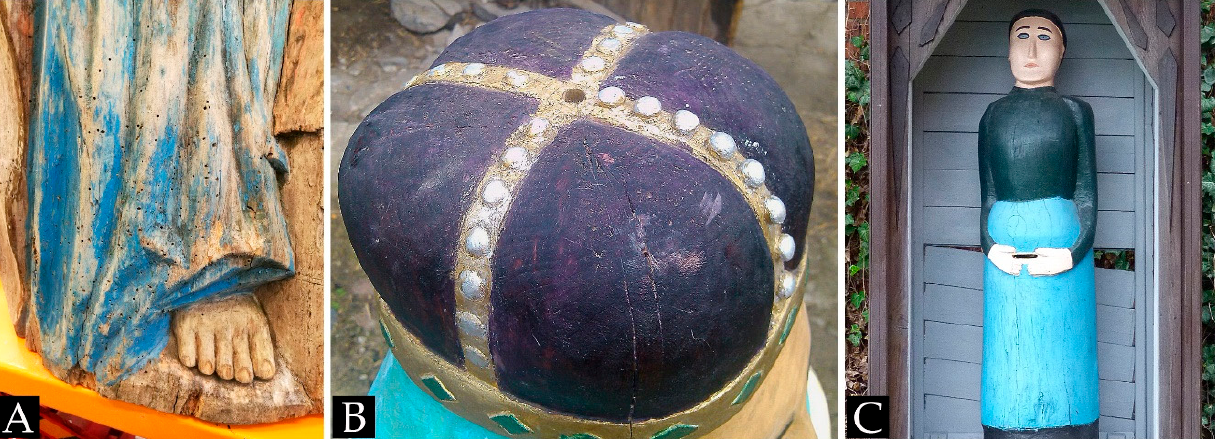
Figure 6. Damage that causes loss of the aesthetic quality of wooden objects (artefacts from the collection of The Museum of Apiculture in Swarz ę dz ( C ), and The National Museum of Agriculture and Food Industry in Szreniawa, Poland ( A,B )).